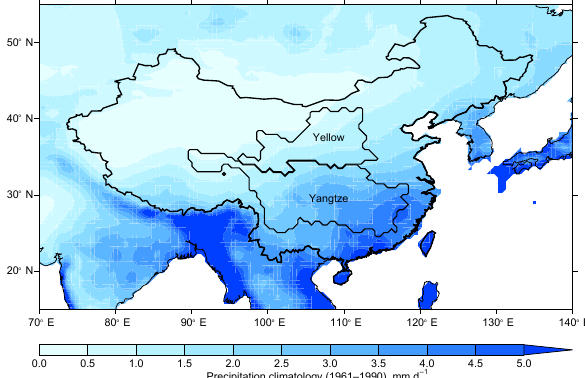
Figure 2. Precipitation climatology for 1961–1990 using the CRU precipitation dataset. This dataset is spatially interpolated, using available in situ observations, to give complete global land cov- erage. The location of the Yangtze and Yellow River catchments within China is shown.